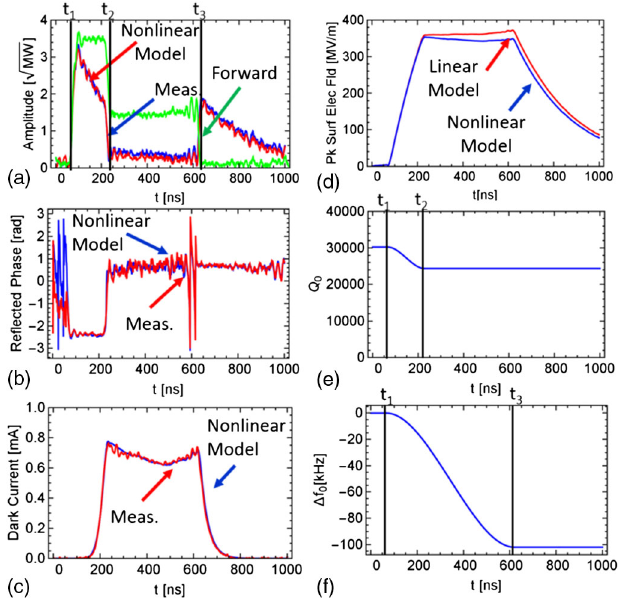
FIG. 3. Measured data (red) for 45 K, also shown in Fig. 2(d) – (f), and nonlinear model (blue) are plotted in (a) – (c). (d) shows the calculated gradient for linear and nonlinear models. (e) and (f) show the predicted change in Q 0 ð t Þ and f 0 ð t Þ ¼ ω 0 ð t Þ = 2 π respectively. Comparing the linear model in Fig. 2(d) – (f) and the nonlinear model in Fig. 3(a) – (c), the nonlinear model better predicts the